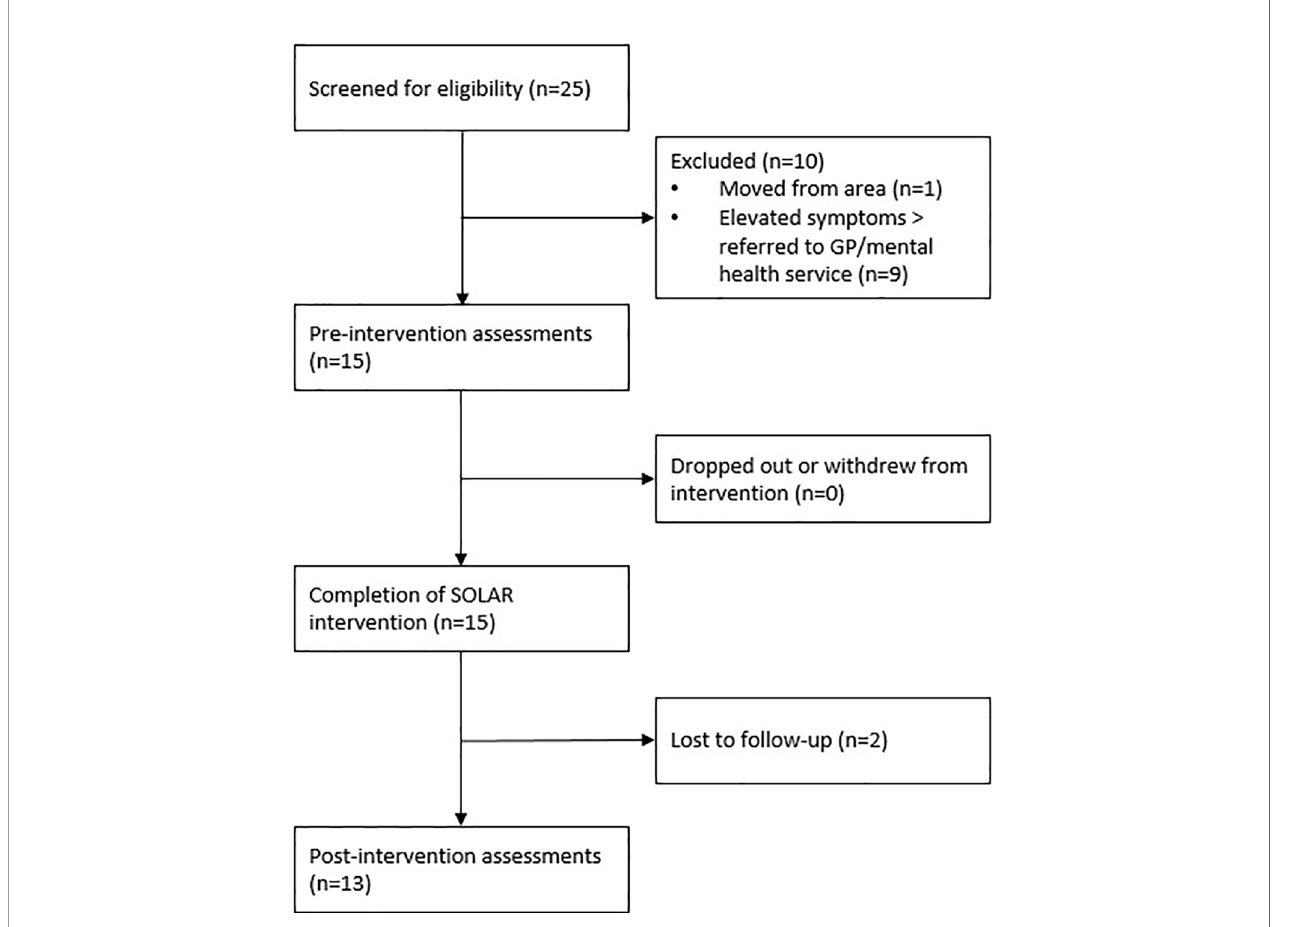
FIGURE 2 | The fl ow of participants recruited to the SOLAR pilot